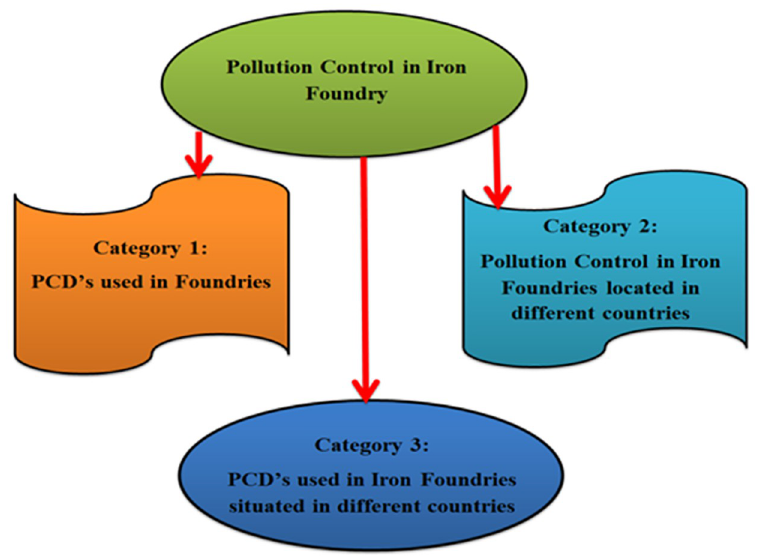
Fig 1. Pollution control in iron foundry